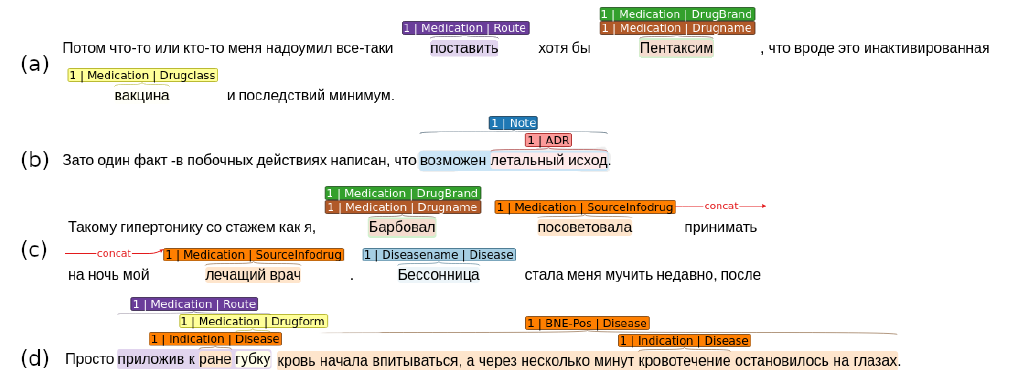
Figure 1. Examples of complex cases in annotation. ( a ) “Then something or someone advised me to still put at least Pentaxim, which seems to be an inactivated vaccine and a minimum of consequences.”, ( b ) “But one fact—in the side effects it is written that a fatal outcome is possible”, ( c ) “For such a hypertensive patient with experience like me, Barboval advised my attending physician to take it at night. Insomnia began to torment me recently” ( d ) “By simply applying a sponge to the wound, the blood began to be absorbed, and after a few minutes the bleeding stopped as before our